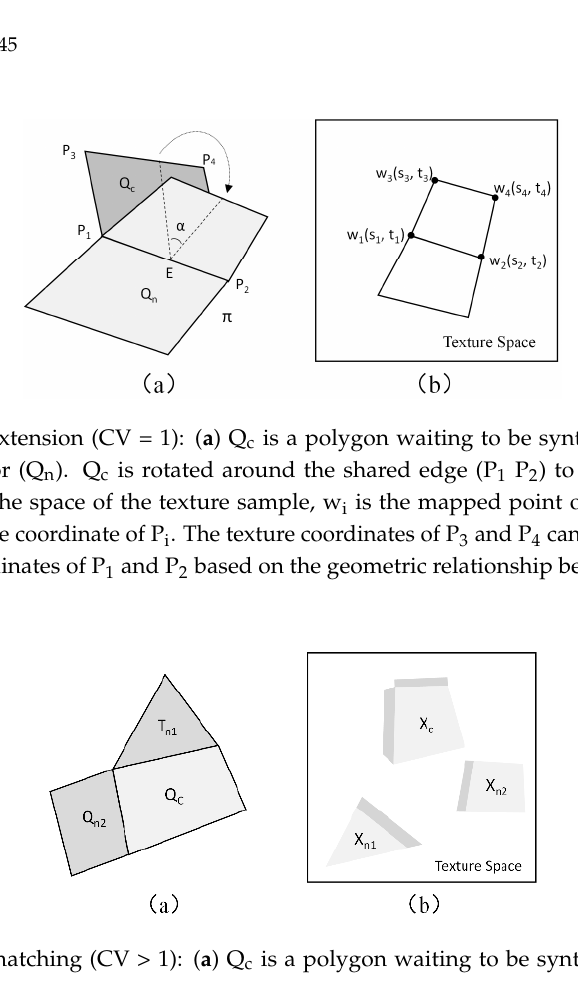
Figure 12. Texture matching (CV > 1): ( a ) Qc is a polygon waiting to be synthesized and has two synthesized neighbors (Tn1 and Qn2). ( b ) In the texture space, Xn1 and Xn2 are the pixel blocks used to texture Tn1 and Qn2, respectively. Some pixel block Xc, two borders of which have the maximal similarity to the borders of Xn1 and Xn2, will be the optimal pixel block for Qc.